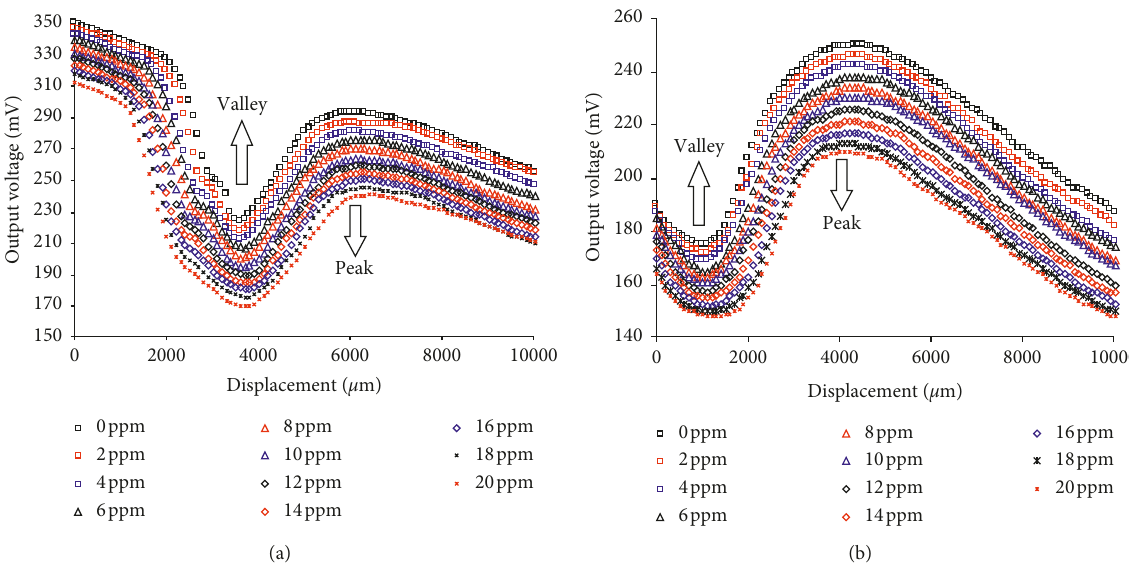
Figure 5: The curve of output voltage against displacement of (a) concentric bundle probe and (b) a pair bundle probe for rhodamine B solution with different concentrations.